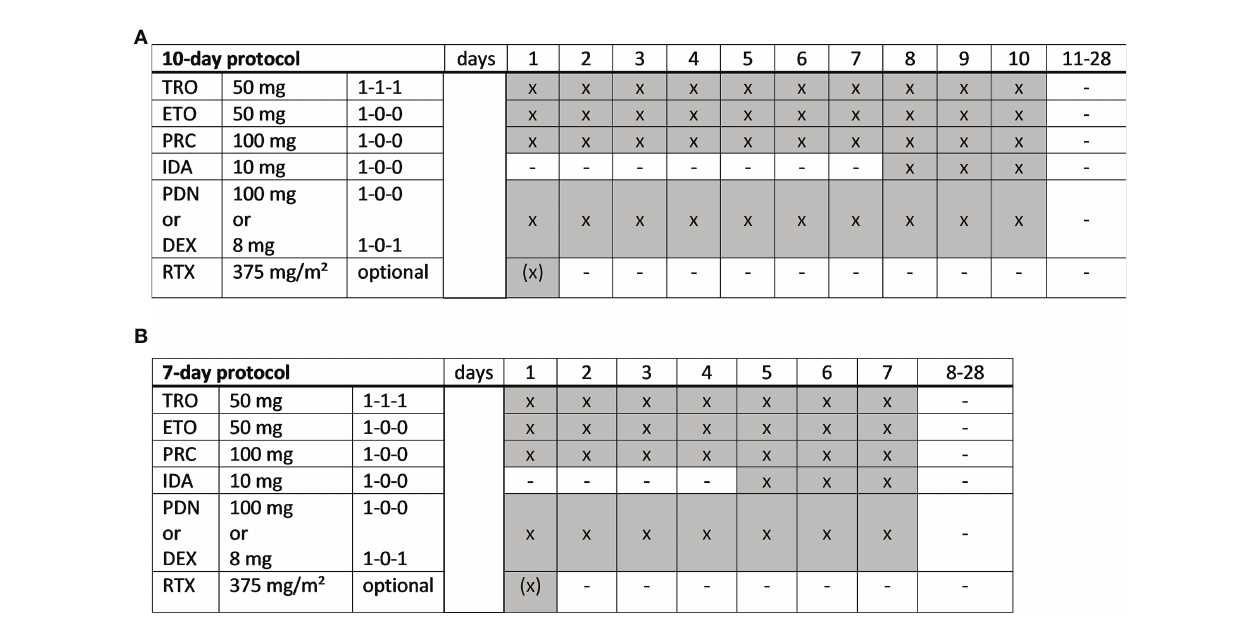
FIGURE 1 | TEPIP schedules. (A) A full-dose, 10-day or (B) a dose-reduced, 7-day protocol was applied depending on the patient´s performance status and expected toxicity tolerance. TRO, trofosfamide; ETO, etoposide; PRC, procarbazine; IDA, idarubicin; PDN, prednisolone; DEX, dexamethasone; RTX, rituximab. x = administration; hyphen = no